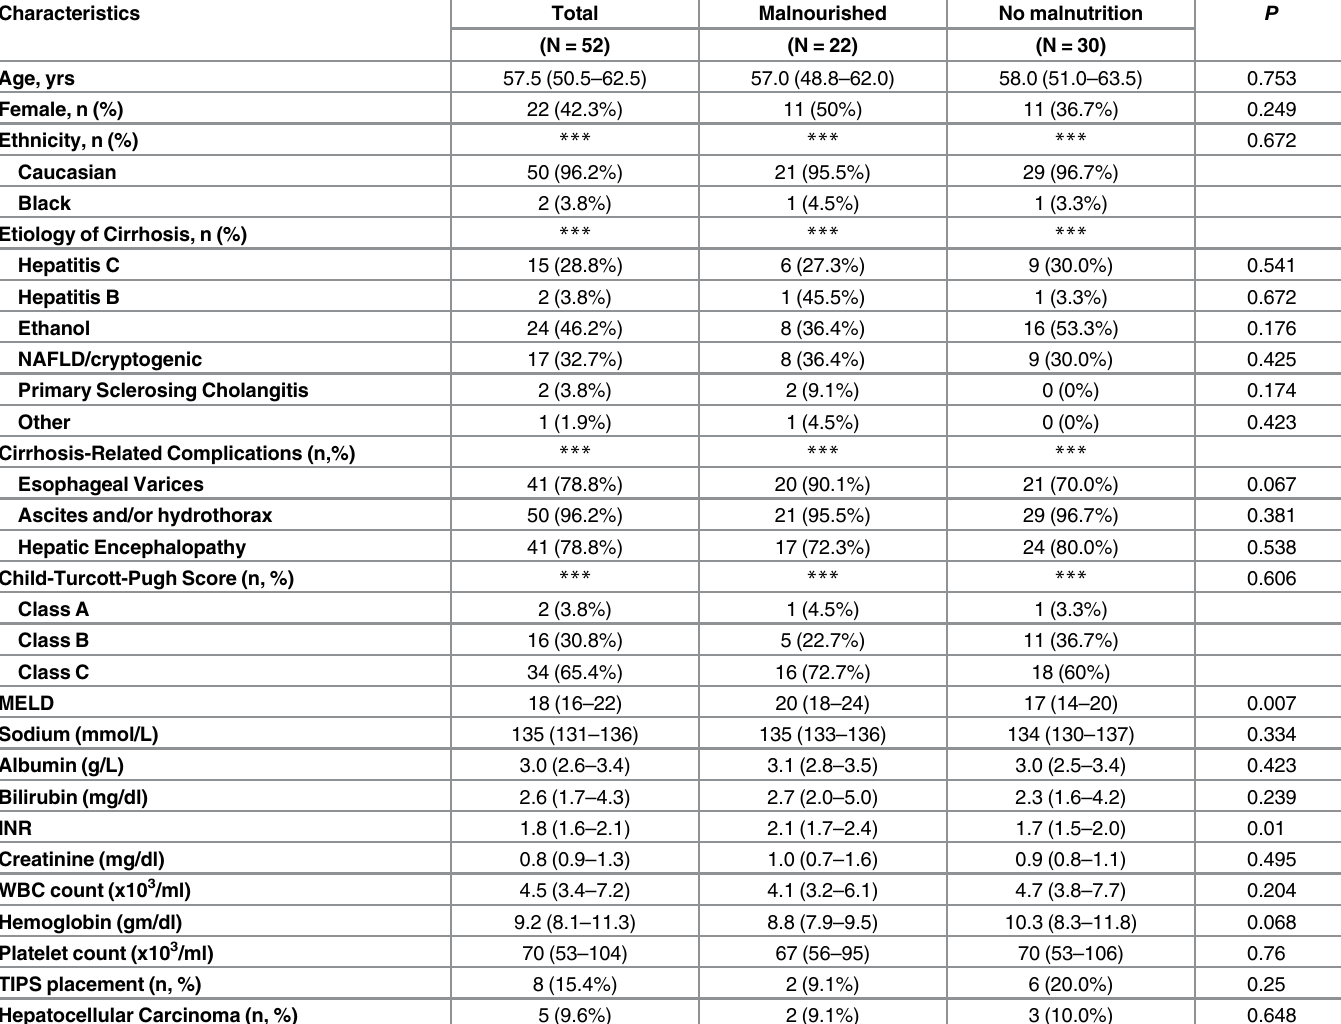
S1 Table, hospitalization diagnoses were similar between patients with and without malnutri- tion, and length of hospitalization was similar between nourished and malnourished subjects Table 1. Clinical and Demographic Characteristics of